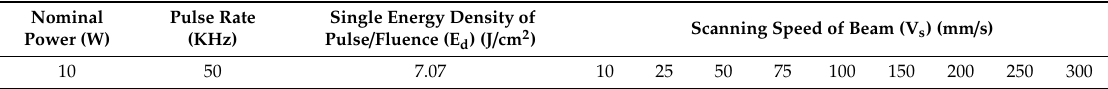
Table 2. Laser processing